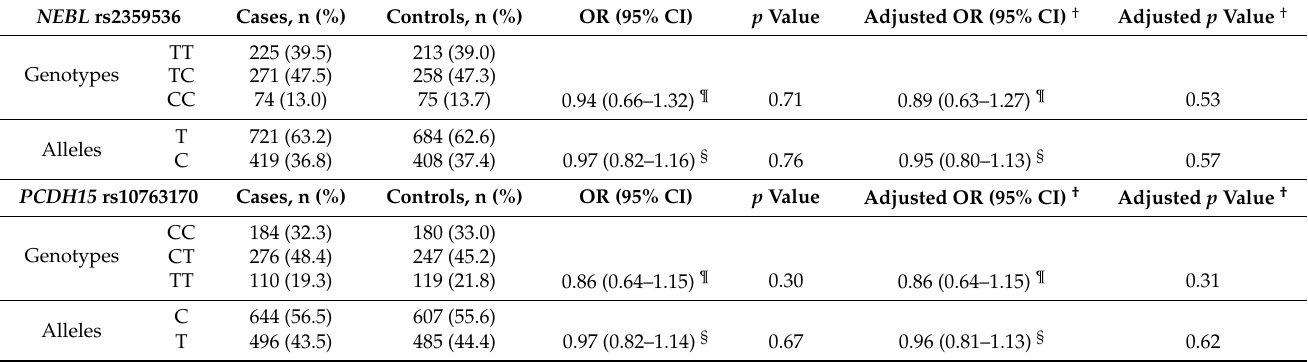
Table 1. Distribution of NEBL , PCDH15 and CDK8 genotypes and alleles in sporadic pituitary adenomas and